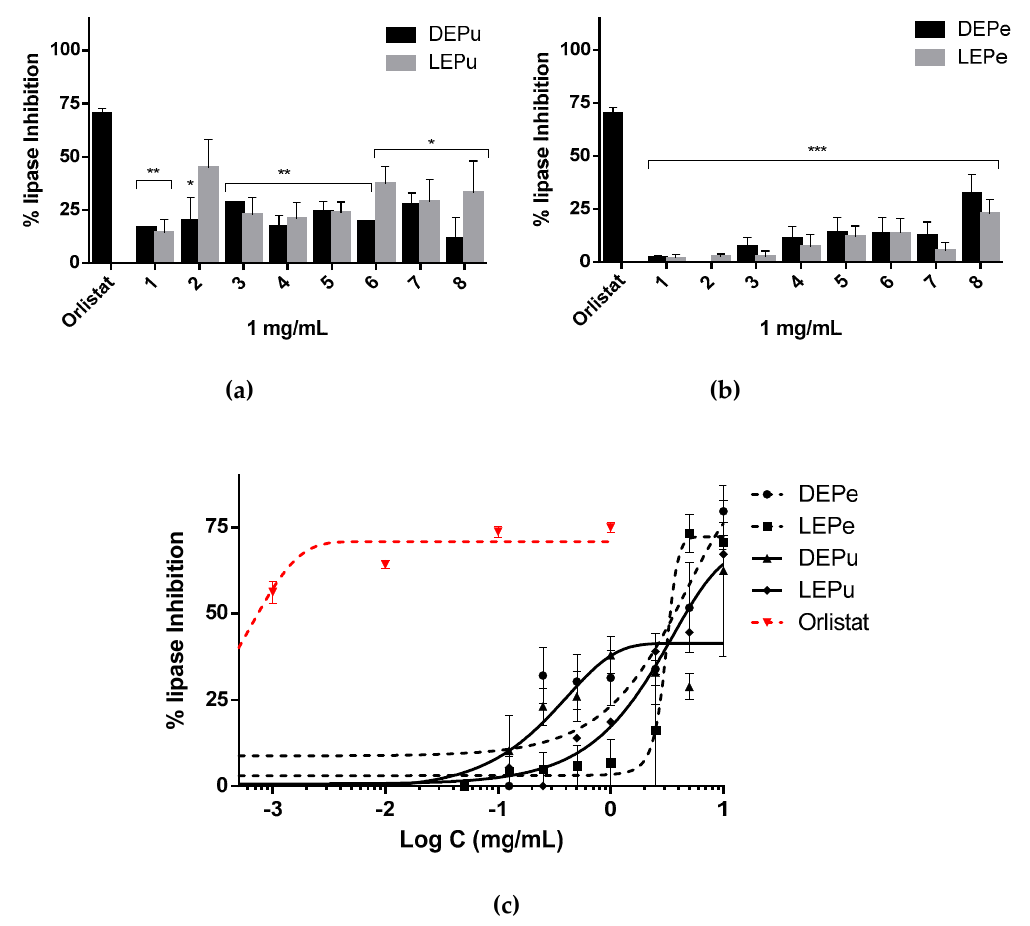
Figure 2. Lipase inhibition: ( a ) inhibition performed by extracts obtained from pulp ( n = 3); ( b ) inhibition performed by extracts obtained from peel ( n = 3); ( c ) inhibition performed by by sample 5 for DEPe and DEPu, sample 6 for LEPe and LEPu, and orlistat in a concentration dependent manner ( n = 3). One-way analysis of variance (ANOVA) followed by Dunnet’s test for multiple comparisons: * p < 0.05; ** p < 0.01; *** p < 0.001 against orlistat. DEPe: dried peel methanolic extract; LEPe: lyophilized peel methanolic extract; DEPu: dried pulp methanolic extract; LEPu: lyophilized pulp methanolic extract.